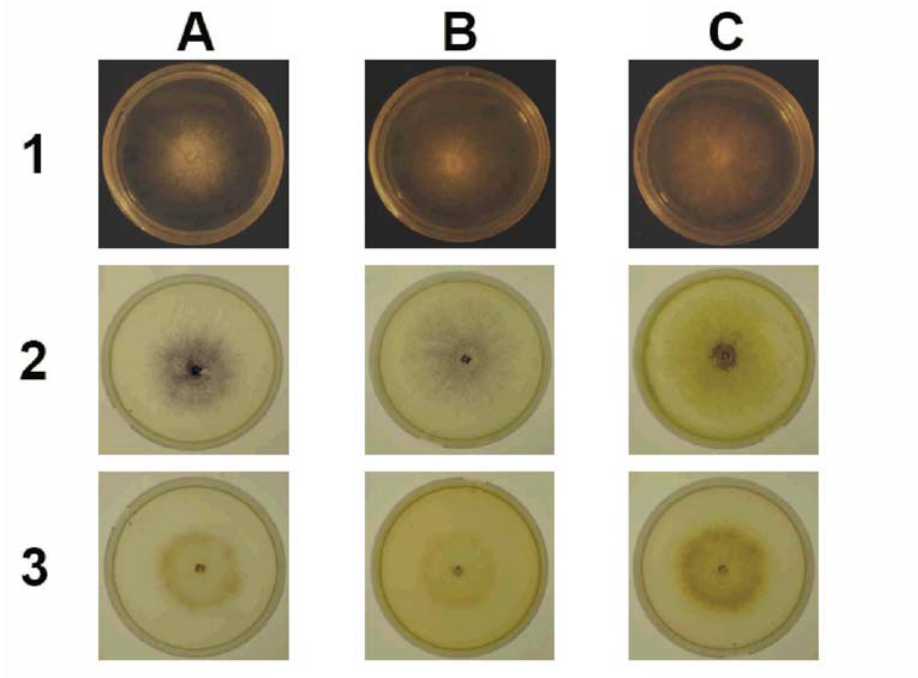
Fig. 6. Botryosphaeria parva growth on a Czapek Dox modi fi ed solid medium with 2.5 mg ml-1 antioxidant supple- ment: (A) control; (B) ascorbate; (C) catechin; 1- control; 2- NBT coloration; 3- DAB coloration. Fungal growth, for 3 days in 7 cm diameter Petri dishes.